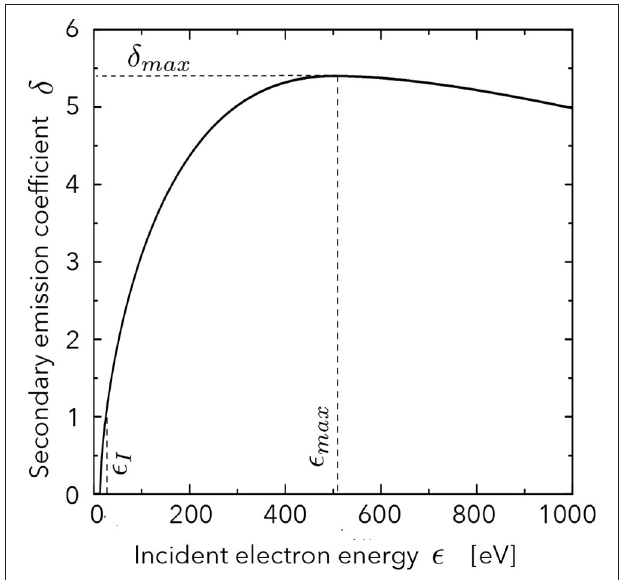
FIGURE 3 | Schematic representation of the electron emission coefficient δ as a function of the incident electron energy ǫ . ǫ I and ǫ max are defined as the electron energy for which δ = 1 and δ = δ max , respectively.